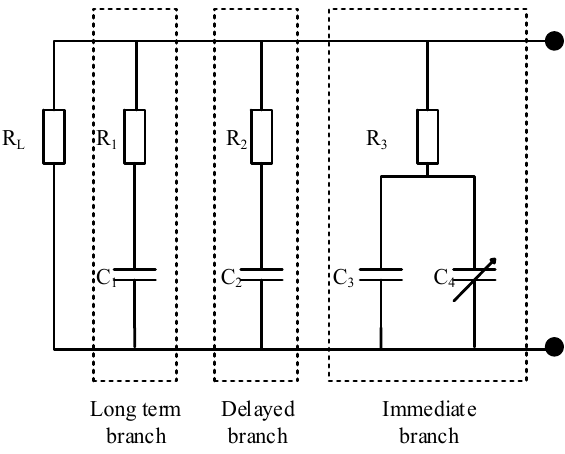
Figure 7. Third-order RC